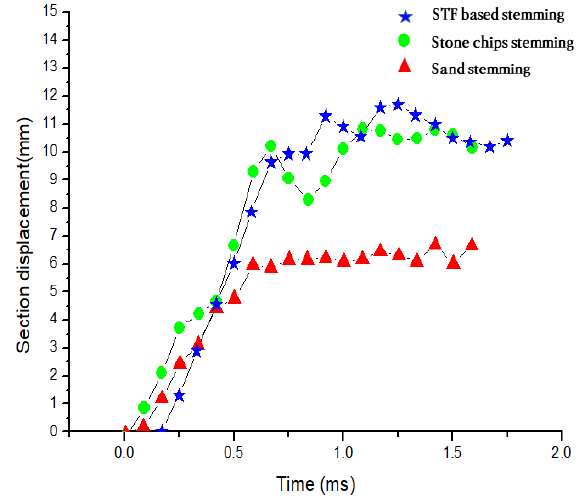
Figure 11. Surface displacement of the lead block after detonating.